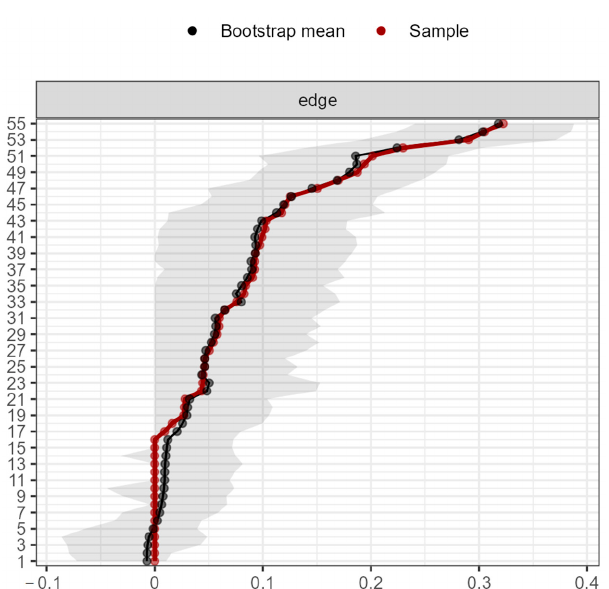
Figure A6. Precision in the estimation of the edges (red line, in the order of the highest to the lowest), and the 95% confidence interval of the estimates (gray line) for the network in the ‘year’ moment, estimated with the non-parametric bootstrap procedure.